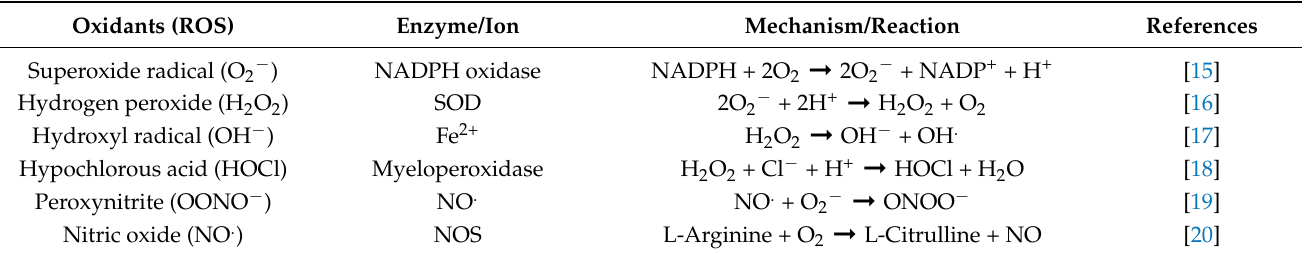
Table 1. Table 1. Mechanism involved in the production of reactive